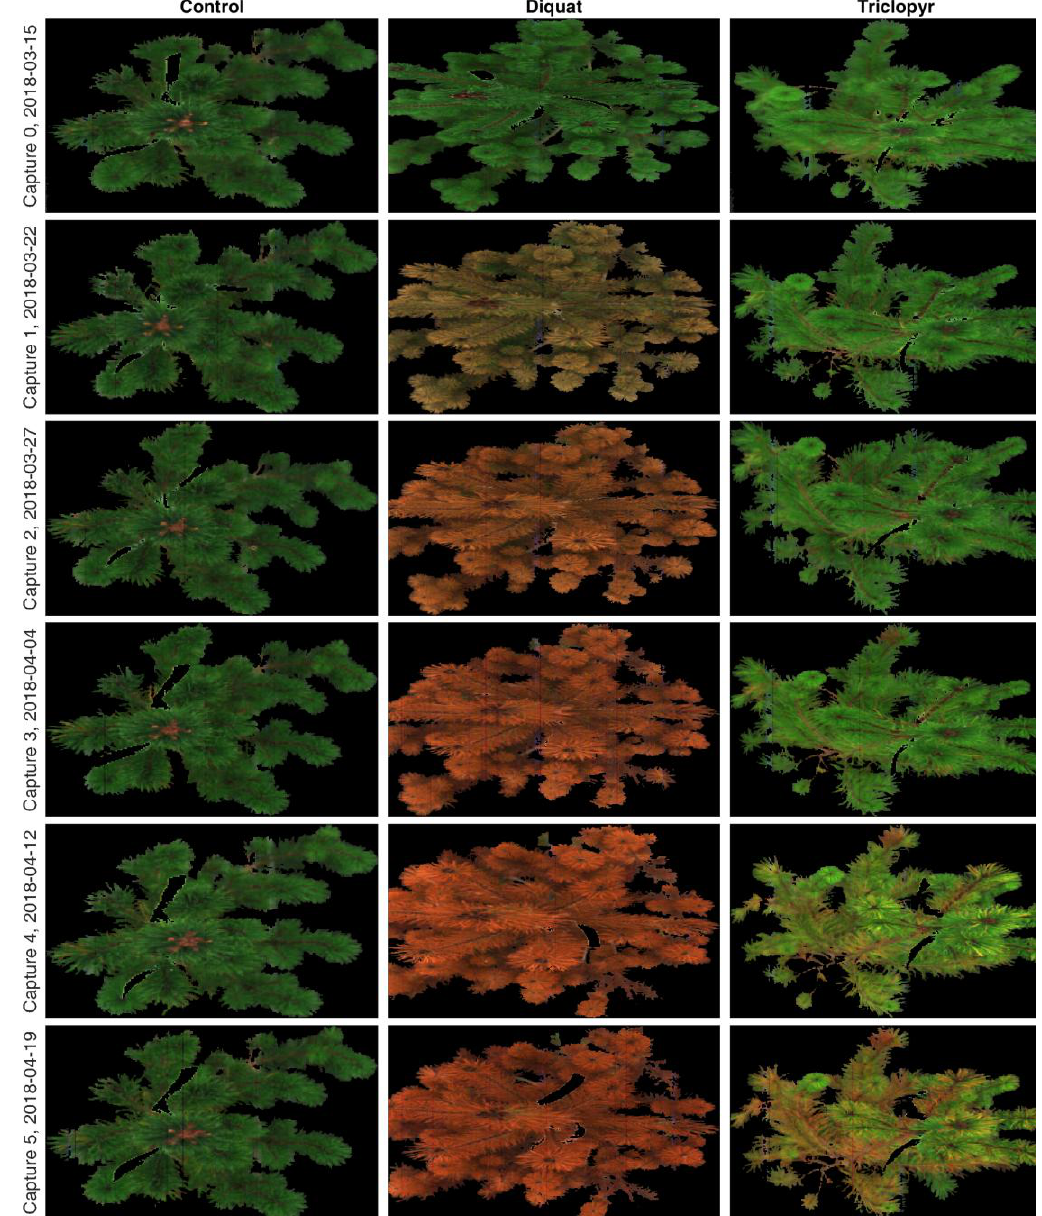
Figure 5. Time series imagery of an example tree from each treatment prior to treatment (Capture 0) and for the five weeks following treatment (Captures